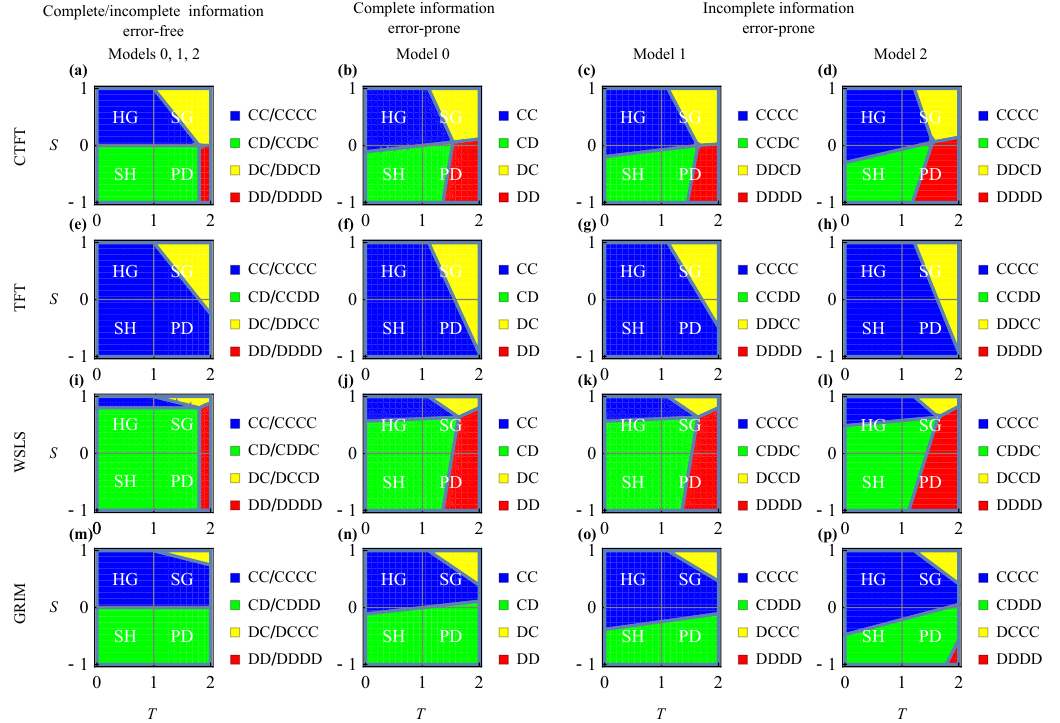
Figure 3. Optimal policies with an intermediate future discount. Here, the opponent obeys ( a – d ) CTFT, ( e – h ) TFT, ( i – l ) WSLS and ( m – p ) GRIM. (a,e,i,m) Error-free cases ( (cid:101) = µ = ν = 0) of complete and incomplete information (common to Models 0, 1 and 2). (b,f,j,n) Error-prone cases ( (cid:101) = µ = ν = 0.1) of complete information (i.e., Model 0). (c,g,k,o) Error-prone cases ( (cid:101) = µ = ν = 0.1) of incomplete information (i.e., Model 1). (c,g,k,o) Error-prone cases ( (cid:101) = µ = ν = 0.1) of incomplete information (i.e., Model 2). Horizontal and vertical axes represent payoffs for one-sided defection, T , and one-sided cooperation, S , respectively. In each panel, Harmony Game (HG), Snowdrift Game (SG), Stag Hunt (SH) and Prisoner’s Dilemma (PD) indicate the regions of these specific games. We set parameter β =